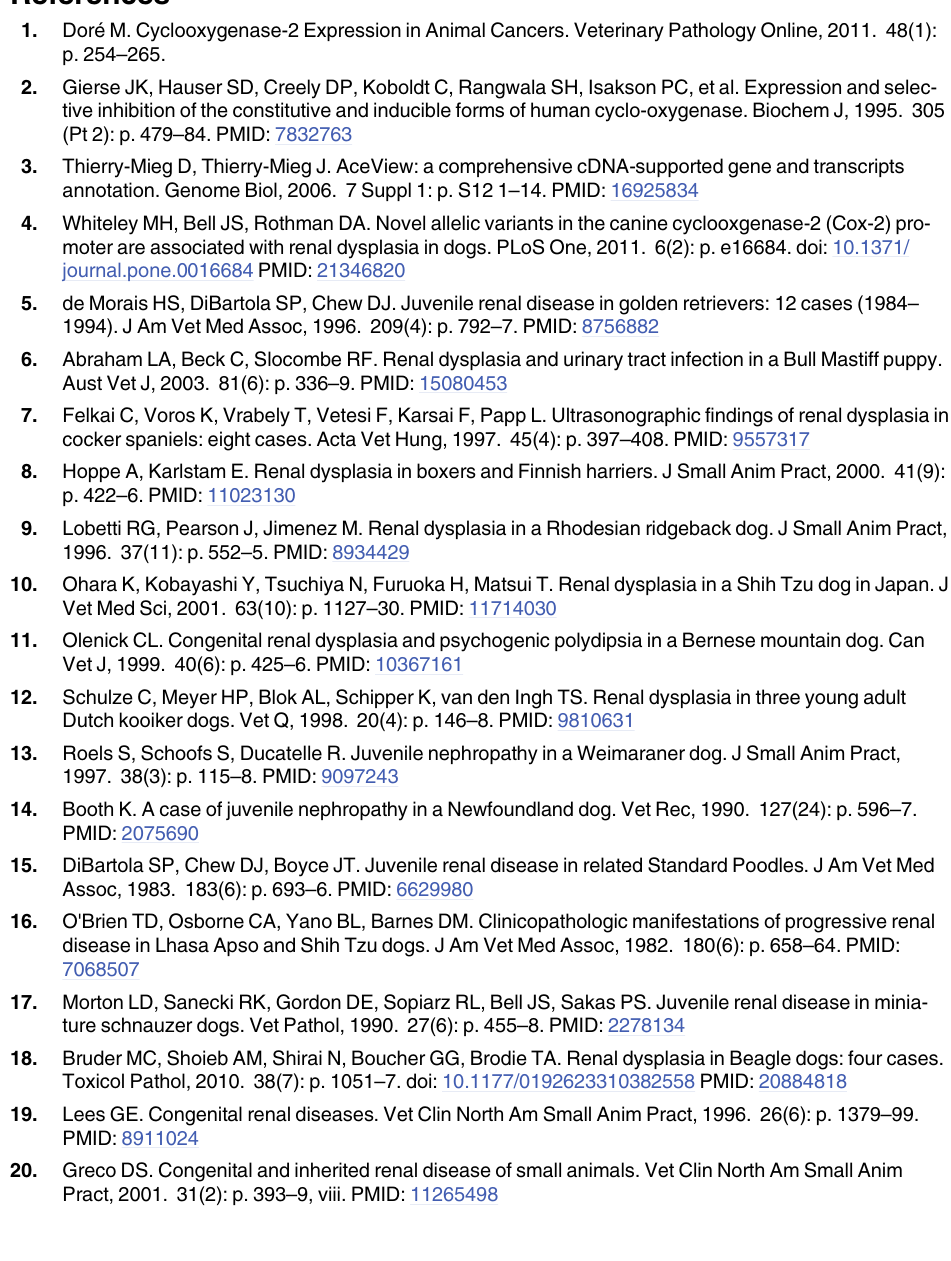
S4 Table. Heterozygosity values observed in 12 Alaskan gray wolves using the canine paren- tal verification panel at the (cid:2) VGL. PIC: Polymorphism Information Content (a value derived to measure the infomativeness of a genetic marker). (cid:2)